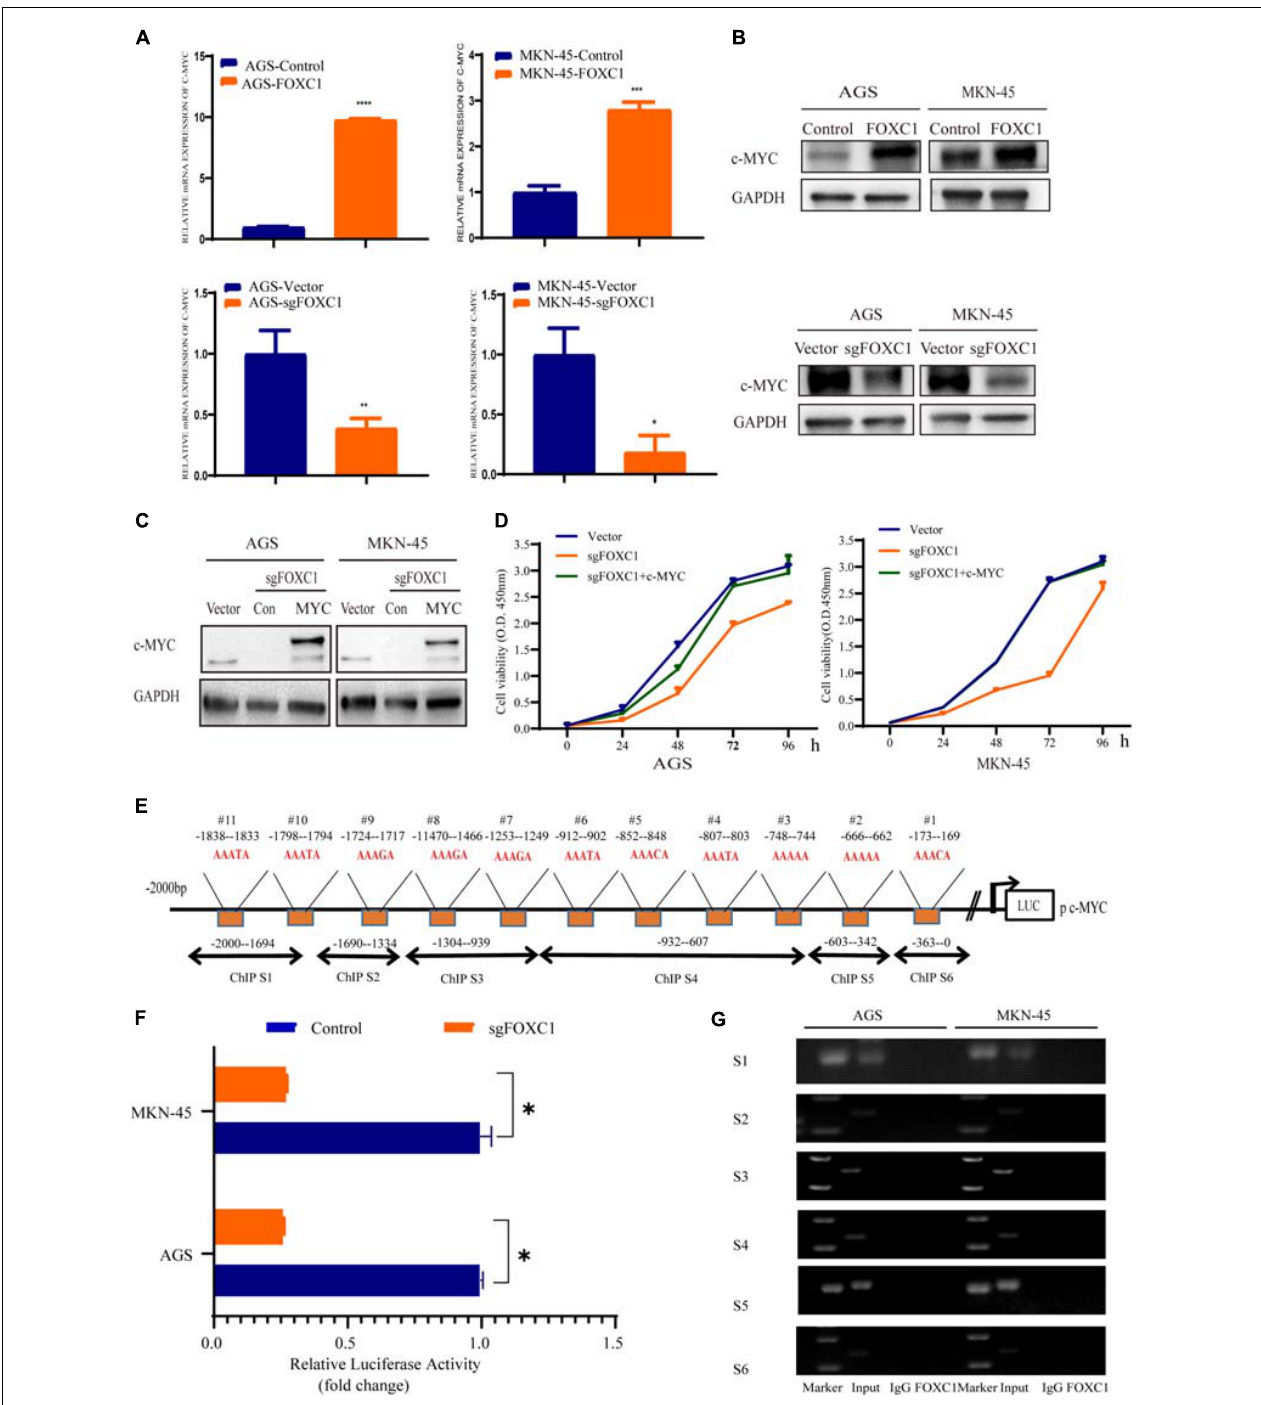
FIGURE 4 | FOXC1 enhances c-MYC expression to regulate gastric cancer cell proliferation. (A,B) The results of qPCR (A) and western blot (B) assays indicated that knockout of FOXC1 in AGS and MKN-45 cells dramatically decreased c-MYC expression but that forced FOXC1 expression in AGS and MKN-45 cells dramatically enhanced c-MYC expression at transcriptional and translational level. Representative figure of the three replicates was shown. (C) Validation of ectopic expression of c-MYC in FOXC1 KO AGS and MKN-45 cells using Western blotting. (D) Ectopic overexpression c-MYC in FOXC1 KO AGS and MKN-45 cells could restore the FOXC1 deficiency-induced phenotype of cell proliferation. All CCK-8 assays were performed three times and showed the same trend and representative results were shown in panel (D) . (E) The putative binding site of FOXC1 in the 5 (cid:48) untranslated regions of c-MYC promoter. (F) A double luciferase activity assay in AGS and MKN-45 cells indicated that FOXC1 regulates c-MYC expression at the transcriptional level. (G) ChIP assay results showed that there was no potential direct binding site of FOXC1 in c-MYC promoter. * P < 0.05, ** P < 0.01, *** P < 0.001, **** P < 0.0001.